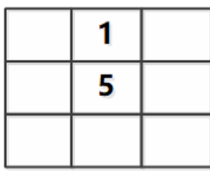
Figure 9. 3 × 3 magic square formation.